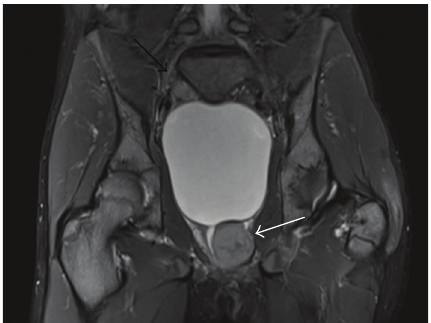
Figure 4: Coronal STIR shows 3 × 4cm mildly hyperintense mass with central linear hypointensity within left lobe of prostate causing deviation of ureter and bladder outlet obstruction (white arrow). A 2 cm mass superior/posterior to the urinary bladder demonstrates similar signal characteristics (black arrow). Diffusely abnormal increased bone marrow signal is also